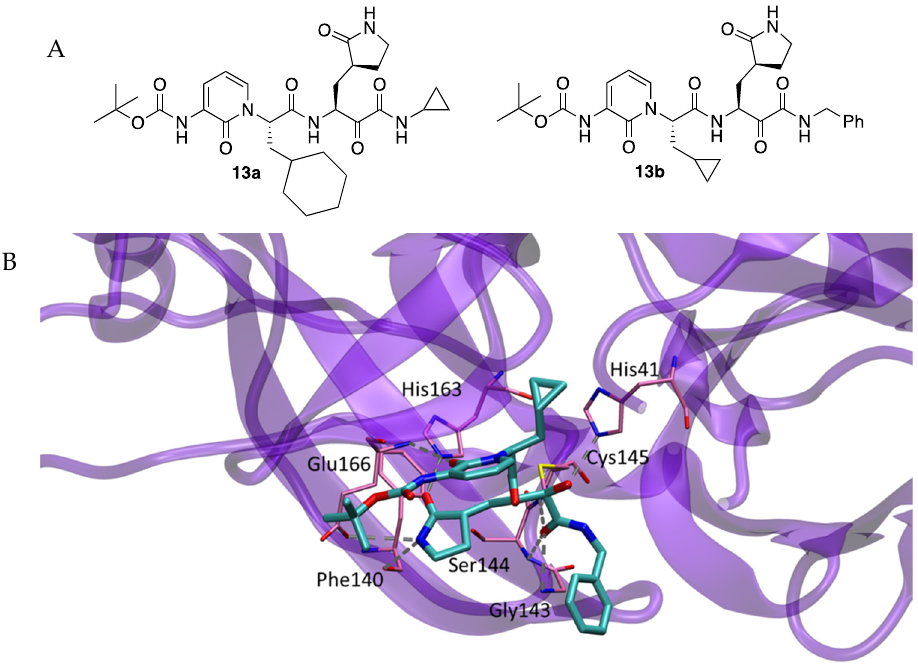
Figure 2. ( A ) Inhibitors 13a and 13b . ( B ) Details of X-ray structure of SARS-CoV-2 Mpro in complex with inhibitor 13b .